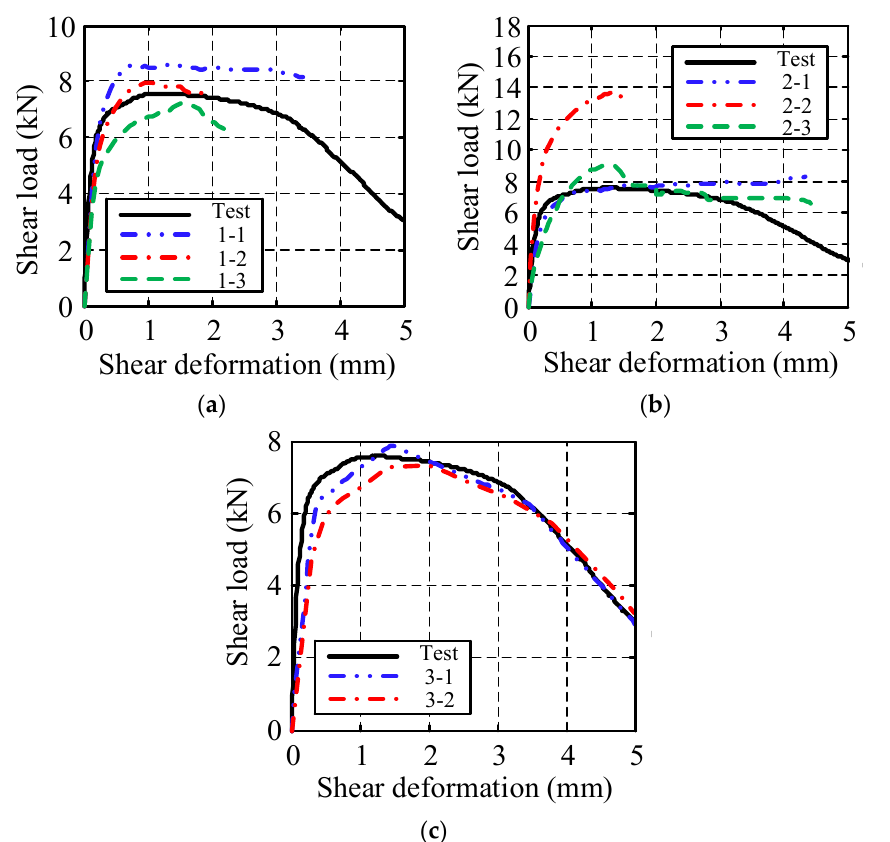
Figure 13. Shear load–deformation curves of the simplified model for the CFS-SPR connection: ( a )